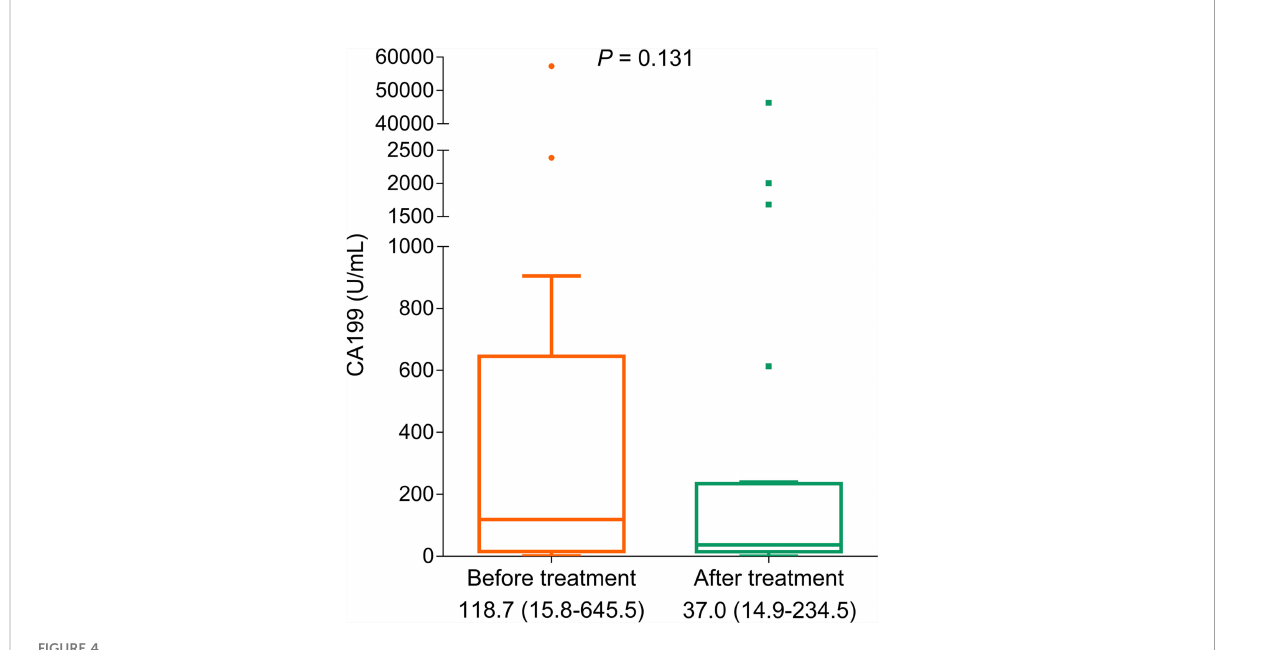
FIGURE 4 Variation of CA199 before and after treatment in BTC